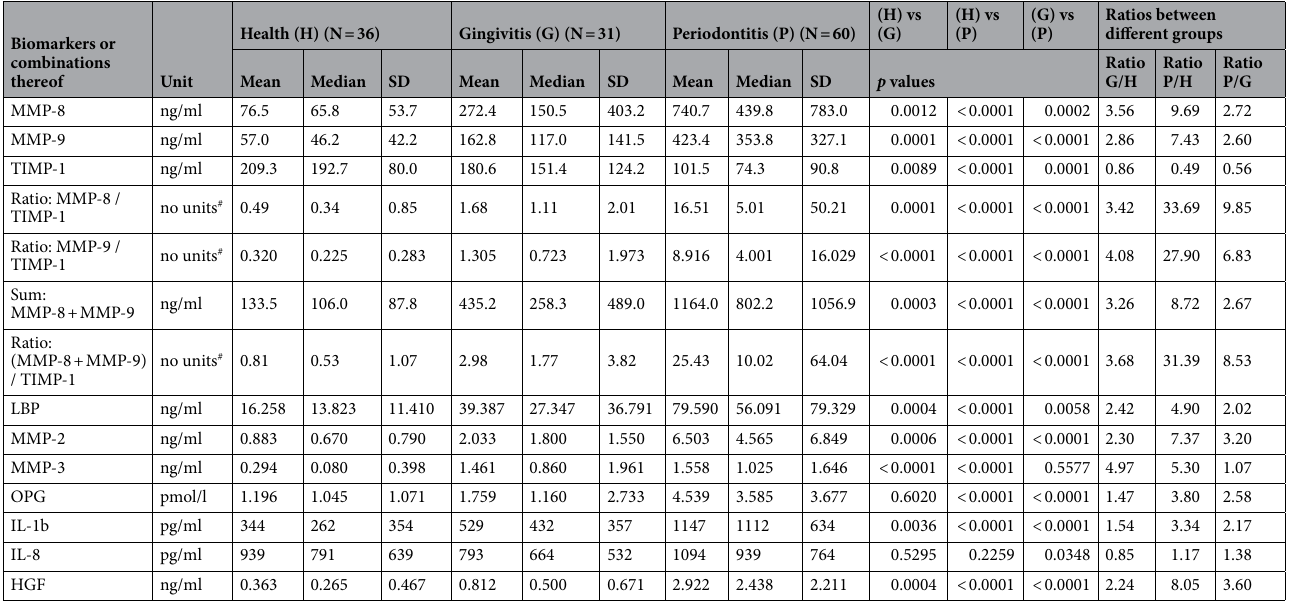
Table 3. Mean and median concentrations of each marker for the three examined groups. # The “ratio” and “combination” values were calculated per sample individually. As it is a ratio, there are no relevant